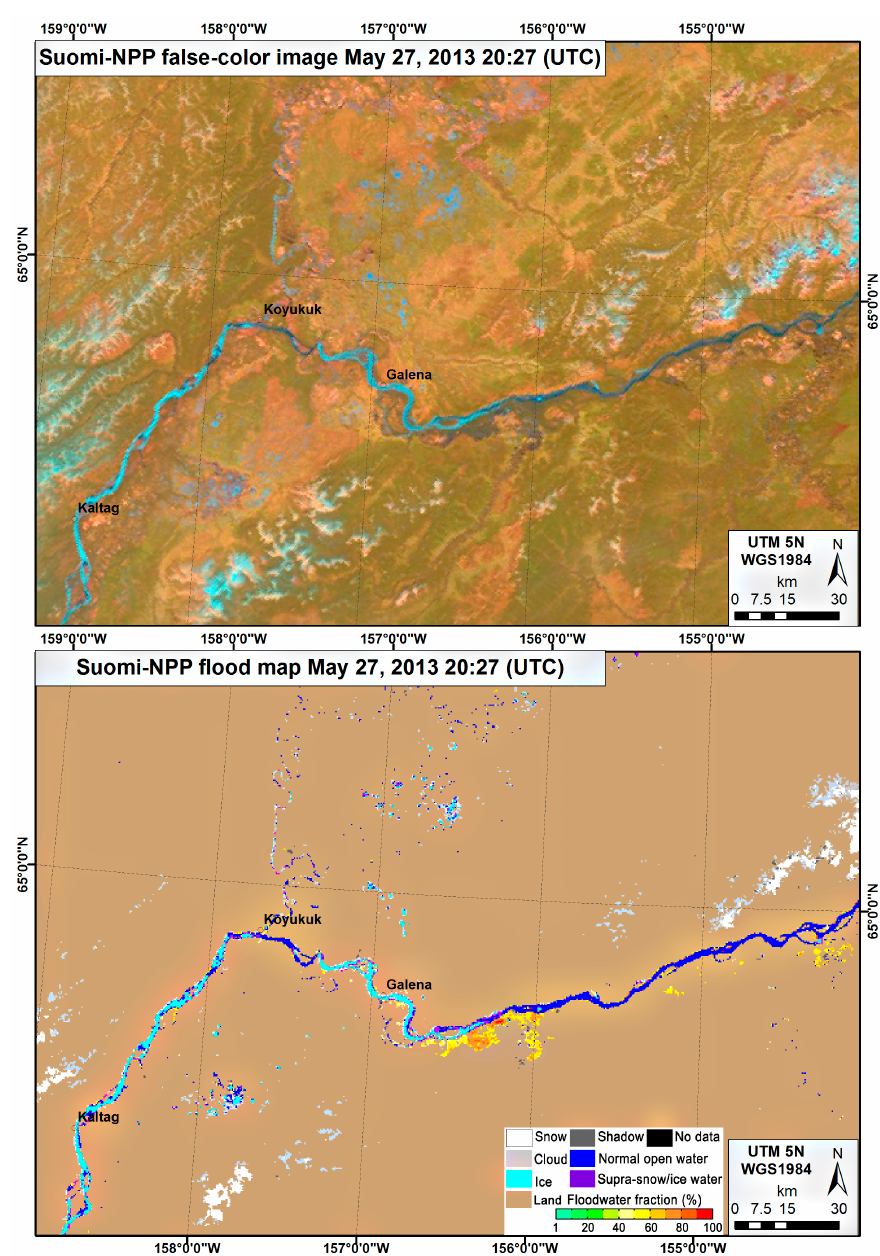
Figure 2. VIIRS false color image ( upper ) and the corresponding flood detection map ( lower ) along the Yukon River in Alaska on May 27, 2013.